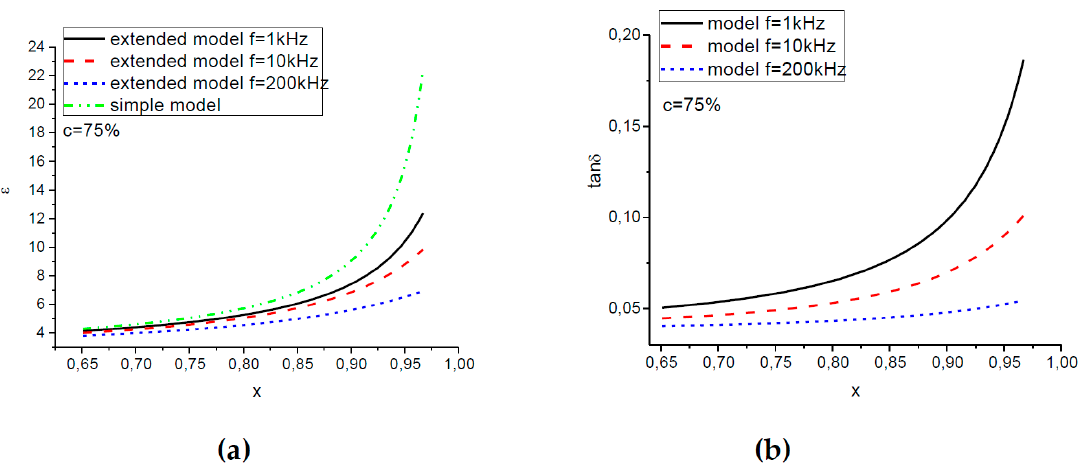
Figure 4. Dependence of ( a ) relative permeability and ( b ) tangent delta on geometrical parameter x. Comparison of new and old models.